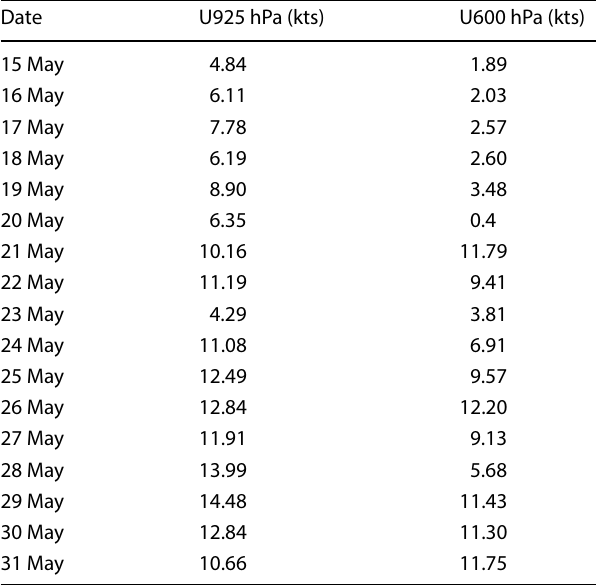
Table 1 The mean zonal (U) wind speed at 925 hPa level over the Oceanic area 5º–10º N, 70º–80ºE and winds at 600 hPa level over the 0–10ºN, 55º–80º